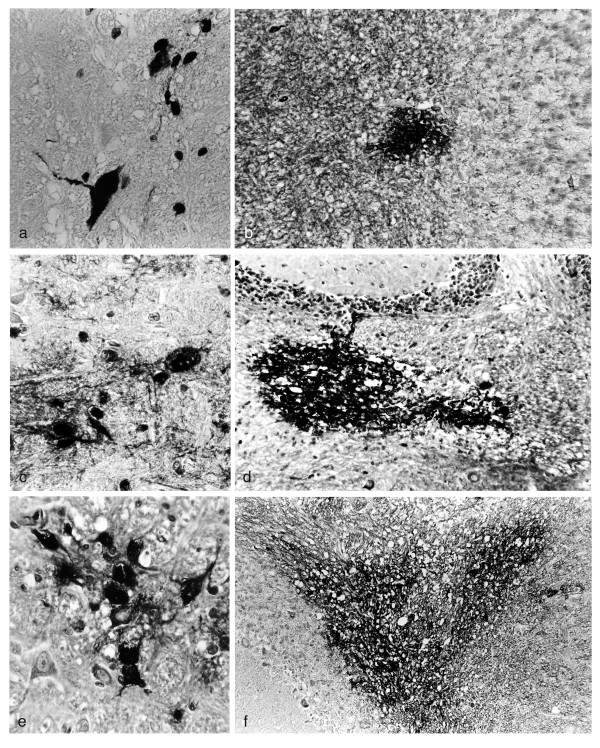
A hierarchy exists among 'focal' areas of HSV-1 antigen positive cells in SJL/J, A/J, and PL/J mice. 'Focal' areas of viral antigen positive cells in serial sections of the BST-CB derived from 3 mice of each strain on day 6, 9, 12, and 15 PI were examined. Serial sections were examined by IHC and the number of 'focal' areas of viral antigen in the BST and CB per slide determined. As one 'focal' area could be present in several serial sections, the greatest diameter of the lesion at a magnification of 400x for the BST and 200x for the CB was recorded. Representative 'focal' areas of HSV-1 antigen positive cells in the BST-CB of virus infected 10-12 week ♀ mice are shown. Representative 'focal' areas in the BST of (a) SJL/J, 9 days PI (x400) (c) A/J, 6 days PI (x400) and (e) PL/J, 6 days PI (x400) mice are shown. Representative 'focal' areas in the CB of (b) SJL/J, 12 days PI (x200) (d) A/J, 9 days PI (x200) and (f) PL/J, 6 days PI (x200) mice are also shown.